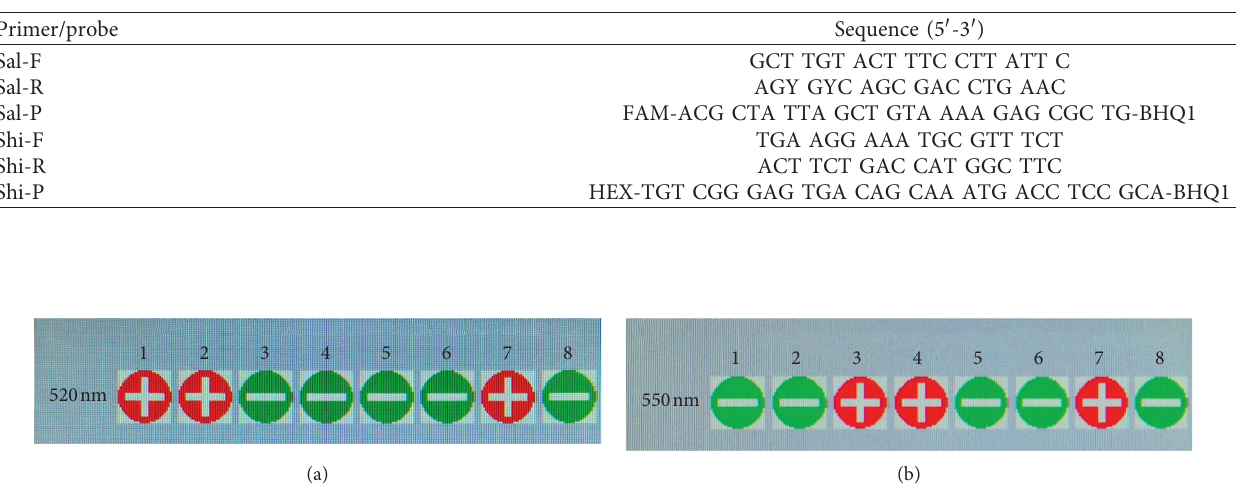
Table 1: Primers and probes used in the iiPCR assay.